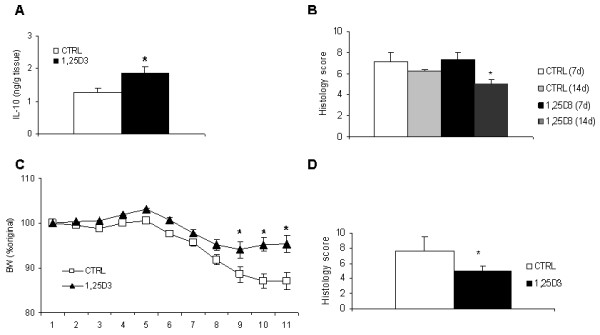
1,25(OH)2D3 ameliorates DSS colitis. A) IL-10 production from the colonic homogenates of control (CTRL) or 1,25(OH)2D3 (1,25D3) fed mice. B) Total histological score was determined for control and 1,25D3 fed mice. C) Percent weight change of CTRL (n = 6) or 1,25D3 (n = 10) treated WT mice when the treatment was given rectally every other day. D) Colonic injury score in rectally treated CTRL and 1,25D3 mice at 10 days post-DSS. *CTRL and 1,25D3 values were significantly different at the corresponding time points.